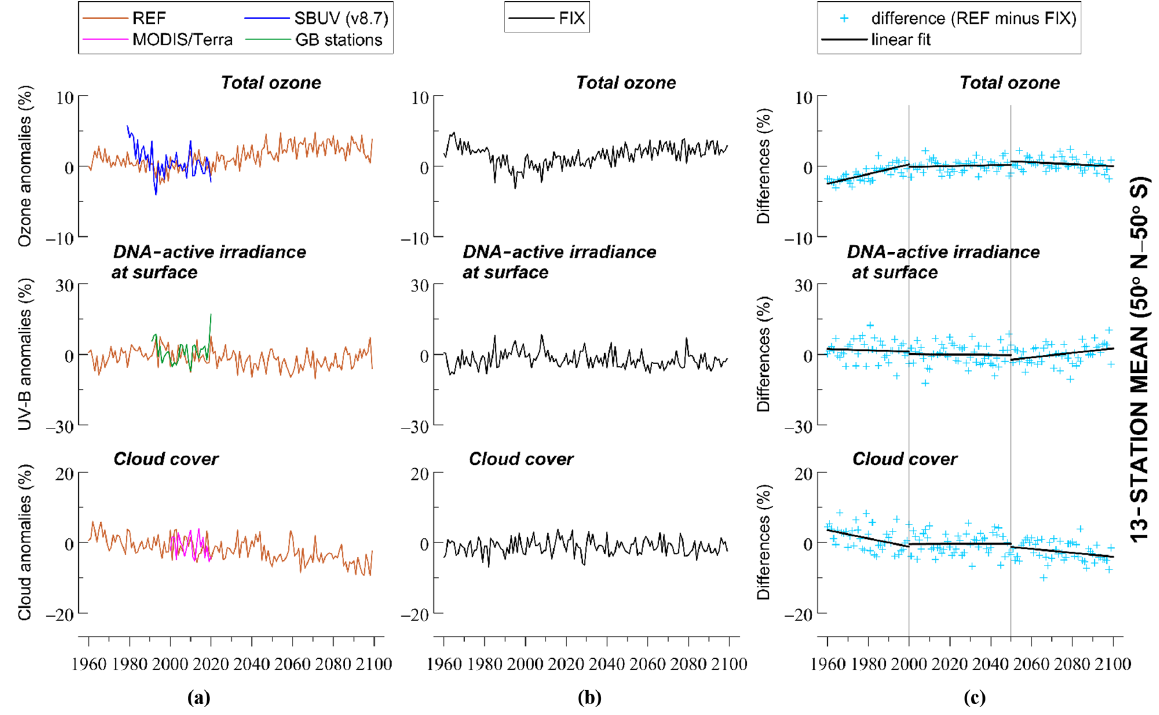
Figure 4. Changes in total ozone, DNA-active irradiance, and cloud cover averaged at 13 UV stations from 50 ◦ N to 50 ◦ S, based on simulations with increasing and fixed-GHG mixing ratios. (a) REF is the simulation with increasing GHGs according to RCP 6.0. (b) FIX is the simulation with fixed-GHG emissions at 1960 levels. (c) Difference between the two model simulations, indicating the impact of increasing GHGs. The y axes in (a) and (b) show yearly averaged data (in %) calculated from de-seasonalized monthly data. The monthly data were de-seasonalized relative to the long-term monthly mean (1990–2019) and were expressed in percent. For stations between 50 ◦ N– 50 ◦ S we used all months to calculate the annual